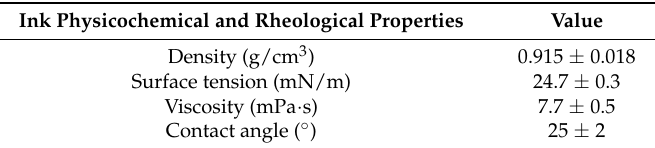
Table 1. Relevant physicochemical and rheological properties of a 0.2 M (in yttrium) SDP-Y 2 O 3 precursor ink with a [DEA]/[Y] ratio of 4.5. Viscosity measurement was carried out at a shear rate of 2880 s − 1 and 25 ◦ C. The contact angle was measured at room temperature on top of unpolished stainless steel from Bruker.